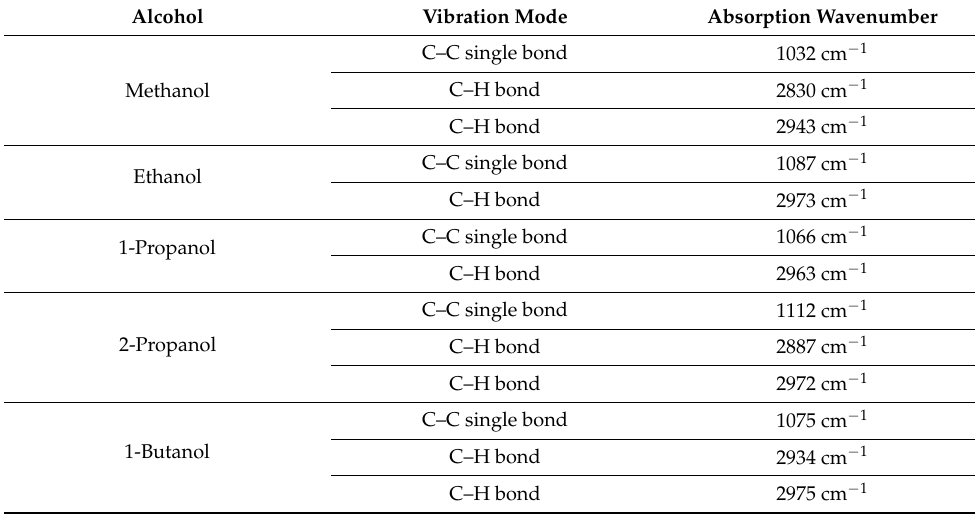
Table 4. Infrared absorption wavenumbers followed for the measurement of diffusion of alcohols in scCO 2